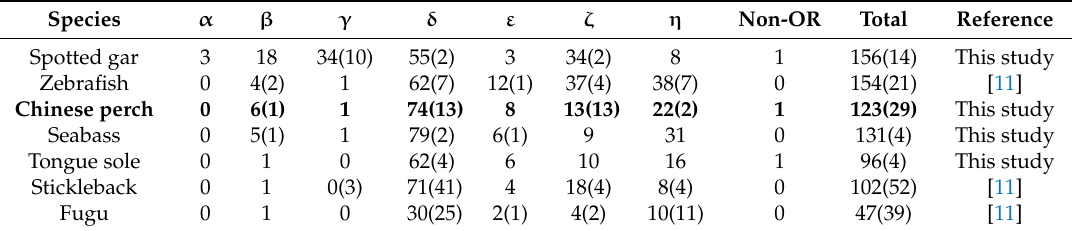
Table 2. Number of functional OR genes and pseudogenes (in parentheses) for each group among different fishes.